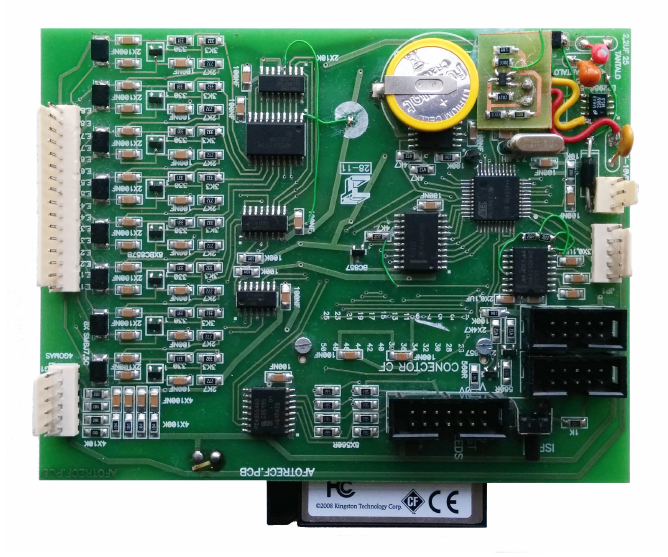
Figure 9. Photo of the hardware